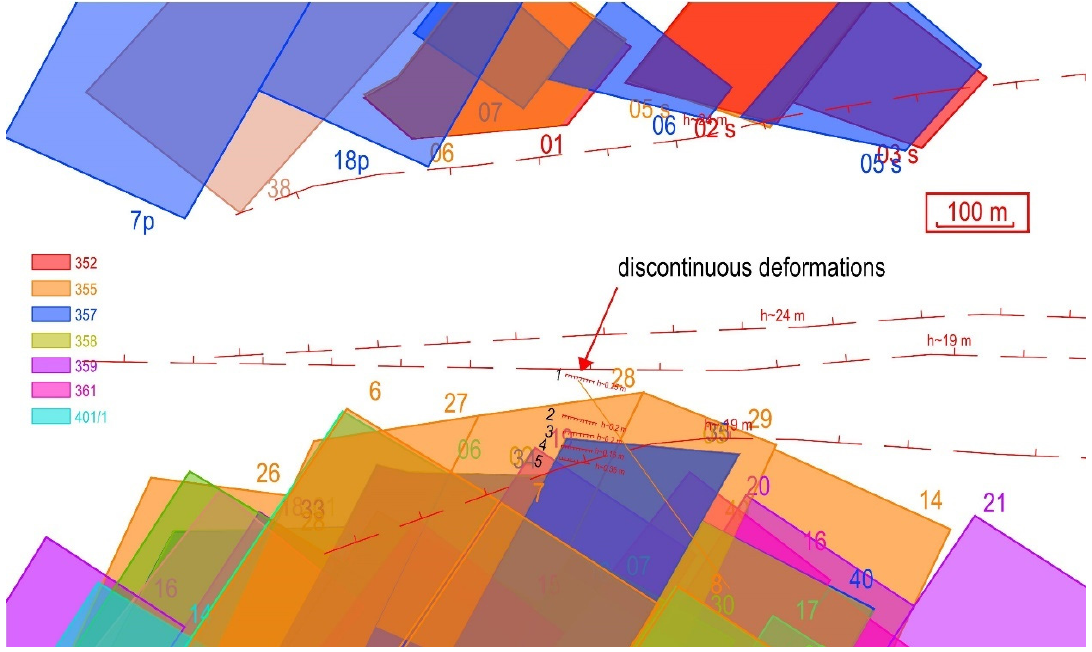
Figure 13. Sketch illustrating all mining exploitations in the study